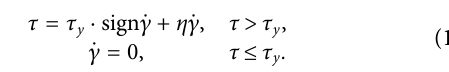
Frontiers in Materials |